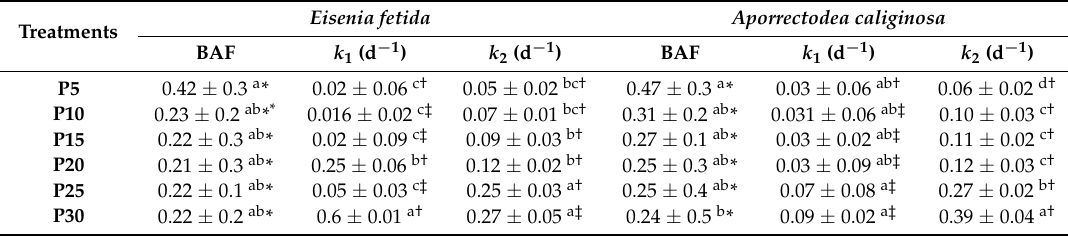
Values presented are means of three replicates with standard error (Tukey’s Studentized Range HSD test p = 0.05). Different letters a, b, c…in the same column (5 values), number of asterisk * in the same row (2 values (BAF only)) and different symbols † and ‡ in the same row (4 values) indicate significant difference.